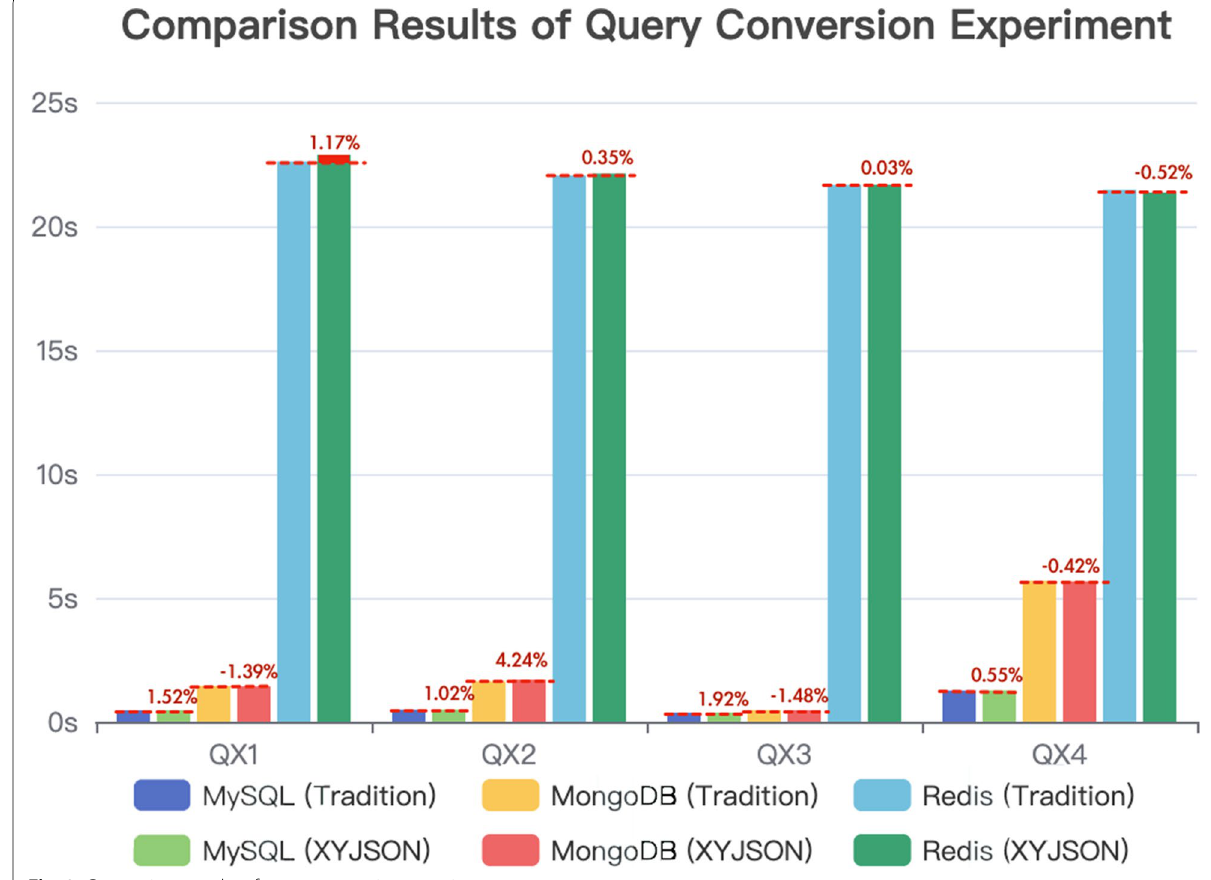
Fig. 8 Comparison results of query conversion